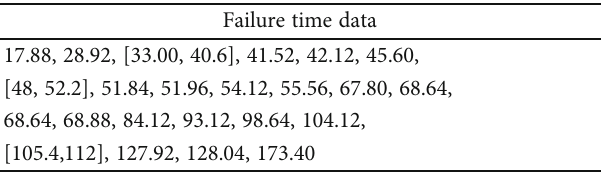
Figure 4: Histogram of the bearing balls